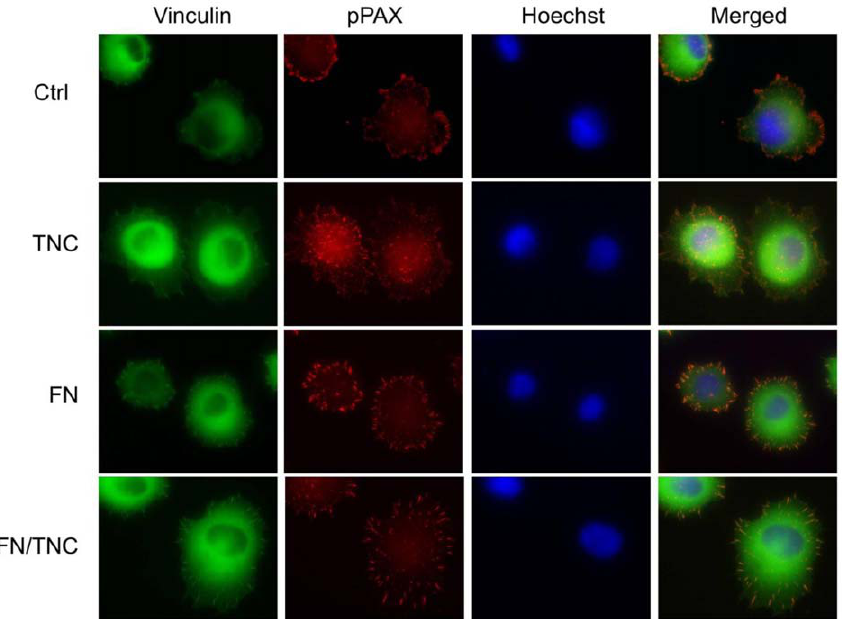
Figure 5. Cellular distribution of phospho-paxillin and vinculin proteins on coated surfaces. PANC-1 cells were let adhere to uncoated or TNC, FN and FN/TNC coated coverslips for 45 min, gently washed, fixed and stained using fluorescent secondary antibodies. Focal adhesion plaques were evidenced by co-localization of vinculin (green) and phospho-paxillin (pPAX, red). Cell nuclei were counterstained with Hoechst 33342.